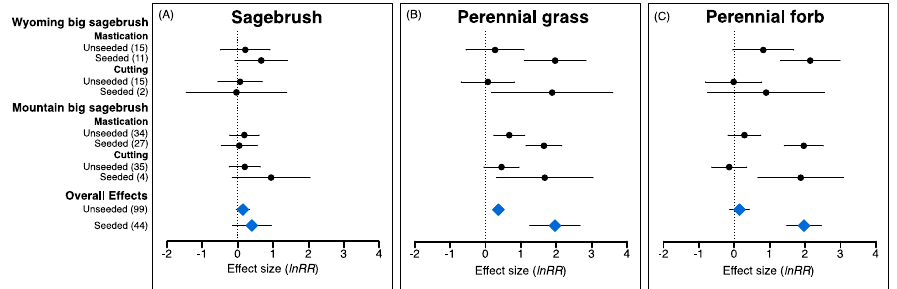
Figure 6. Mean effect sizes and 95% confidence intervals ( lnRR ; pre vs. posttreatment cover) for sagebrush ( A ), perennial grass ( B ), and perennial forb ( C ) responses in three sagebrush community types following pinyon–juniper reduction by mastication and cutting treatments (solid black circles) for unseeded and seeded sites. Overall effects (blue diamonds) indicate effect sizes for all observations; values in parentheses are the number of observations used to calculate effect sizes. E ff ect sizes are considered significantly di ff erent from one another if confidence intervals do not